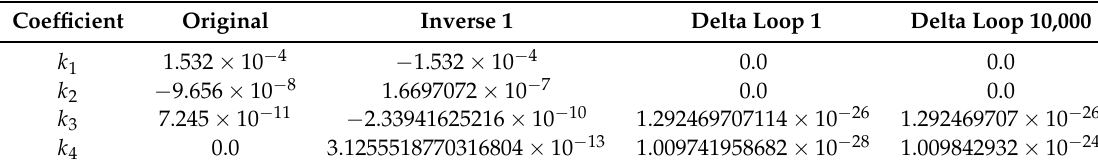
Table 2. Radial distortion inverse loop and residual between coefficients of the orignal distortion and after n inversions ( n = 2 and n =